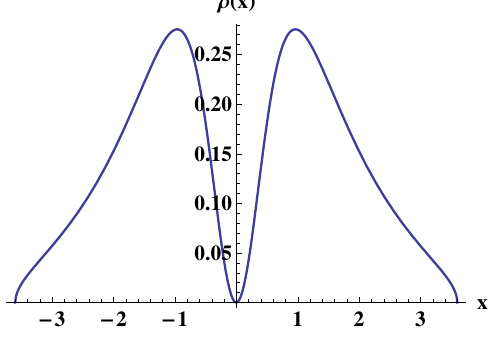
Figure 3 . The eigenvalue density at the critical